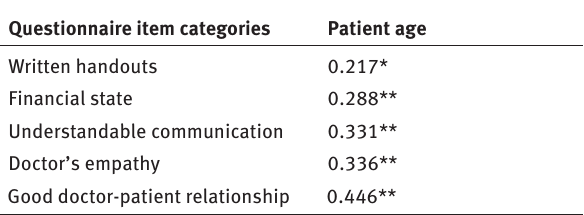
Table 2: Significant correlations between patient age and question- naire results (Pearson correlation coefficients *p<0.05, **p<0.01).